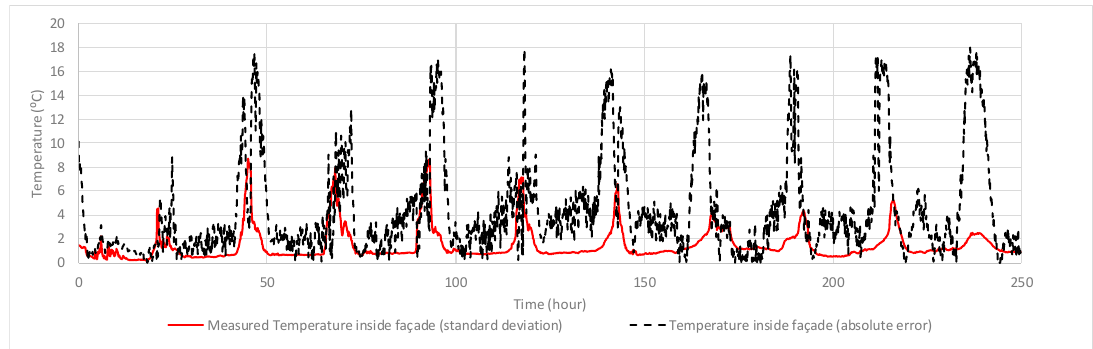
Figure 7. Absolute error of the predicted temperature inside the façade to the standard deviation of the measured value from 5–15 November.